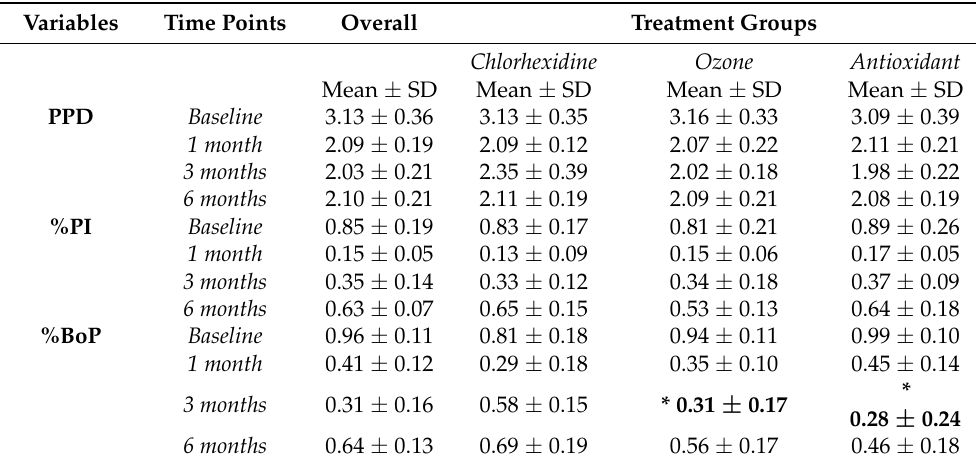
Table 2. Mean values ( ± standard deviations) of clinical periodontal measures at baseline and at one, three, and six months.